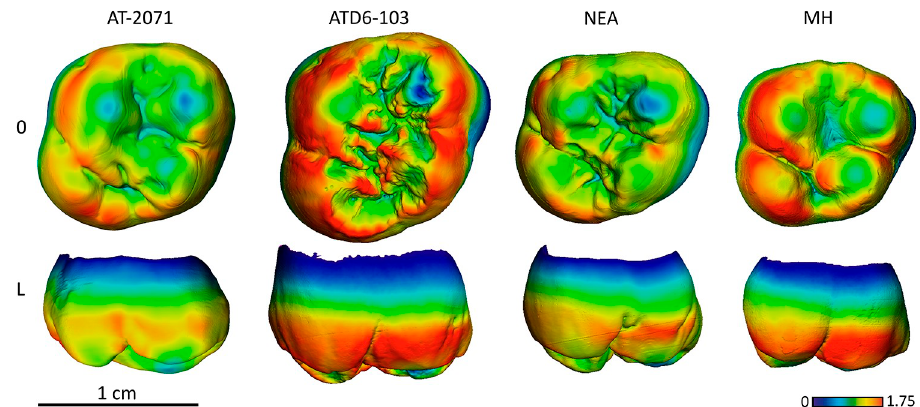
Fig 9. Enamel thickness cartographies of the Atapuerca-SH upper M1 (AT-2071) compared with those of H . antecessor (ATD6-103) from Atapuerca-Gran Dolina, Neanderthal and modern human. Topographic thickness variation is rendered by a pseudo-color scale ranging from thinner dark-blue to thicker red. NEA = Neanderthal (La Quina-H18) and MH = modern human of European origin (O = occlusal, L = lingual). Scale bar = 1.75 for all specimens. (When needed specimens have been mirrored to the left to match the SH specimen).